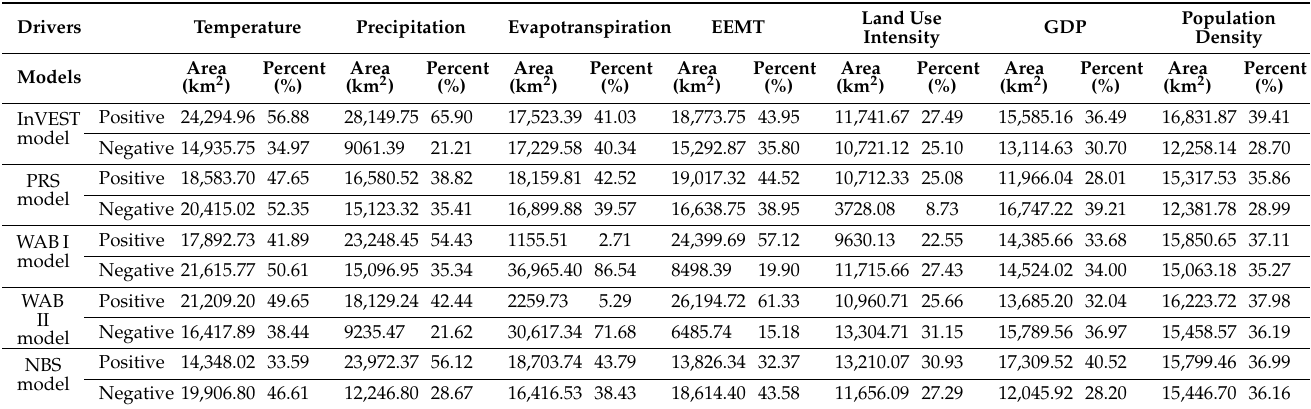
Table 3. Area and percentage of positive and negative correlations between water retention and